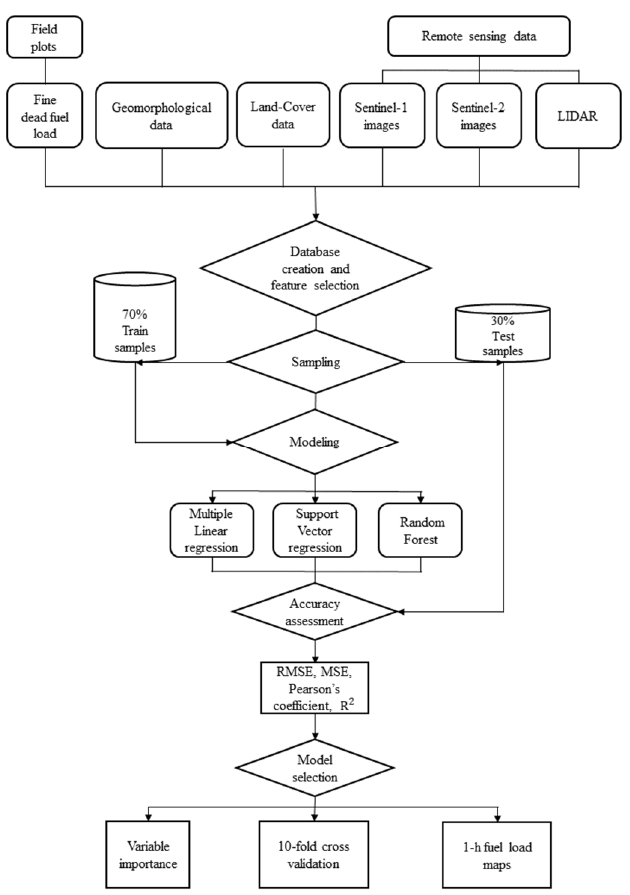
Figure 4. Flow chart of the methodology employed in this study. RSME = Root Mean Squared Error; MSE = Mean Squared Error; R 2 = coefficient of determination.